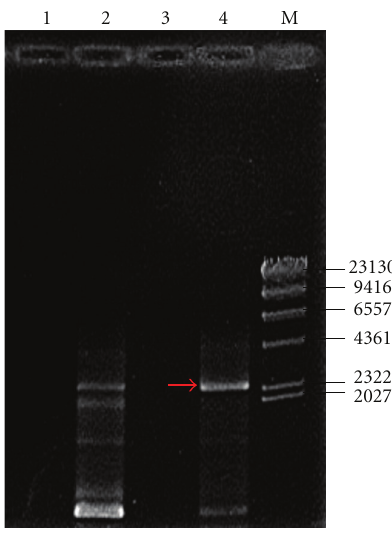
Figure 1: HIF-1 α expression by RT-PCR is shown by the red arrow. Lanes 1 and 3 are negative control and lane 2 denaturated at 58 ◦ C, lane 4 at 62 ◦ C. Lane M is λ DNA/Hind